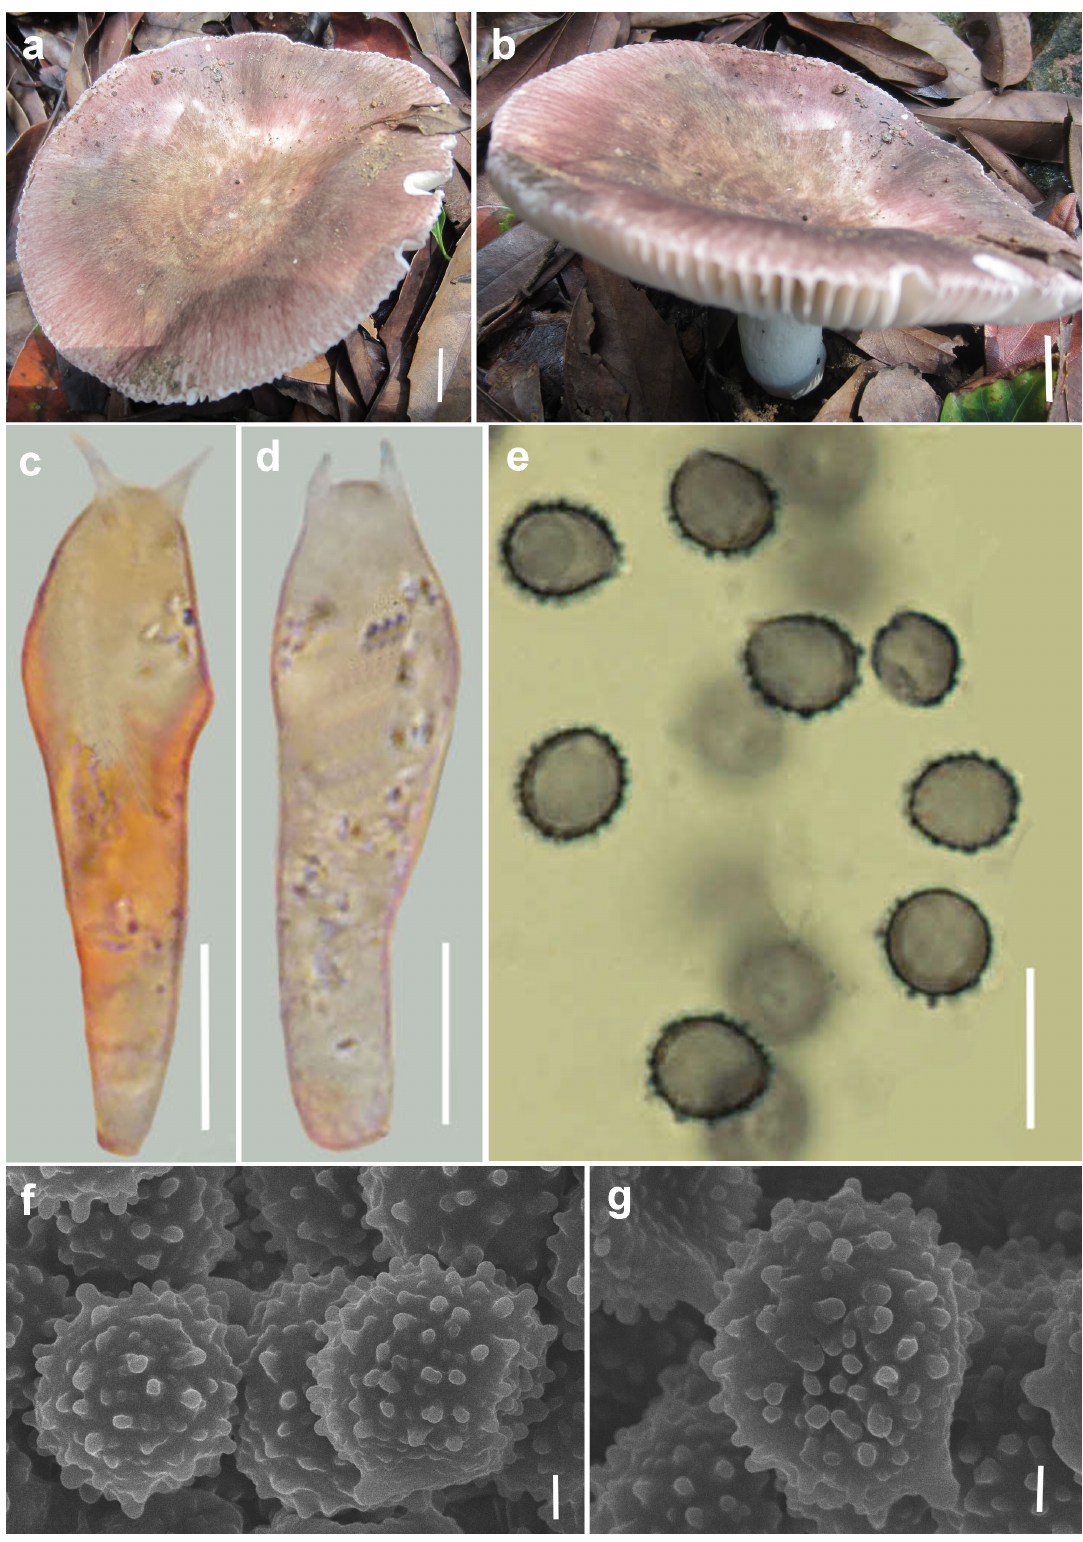
Fig. 2. Russula fusiformata Y.Song sp. nov., holotype (GDGM75333). a–b . Fruiting bodies. c–d . Basidia. e . Basidiospores in Melzer’s reagent. f–g . Basidiospores under scanning electron microscope. Scale bars: a–b = 1 cm; c–e = 10 μm; f–g = 1